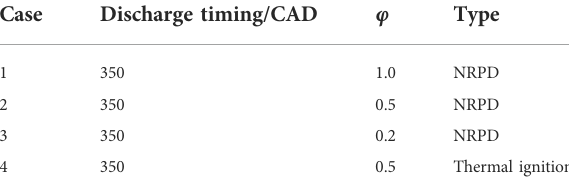
TABLE 3 Initial parameters of simulation